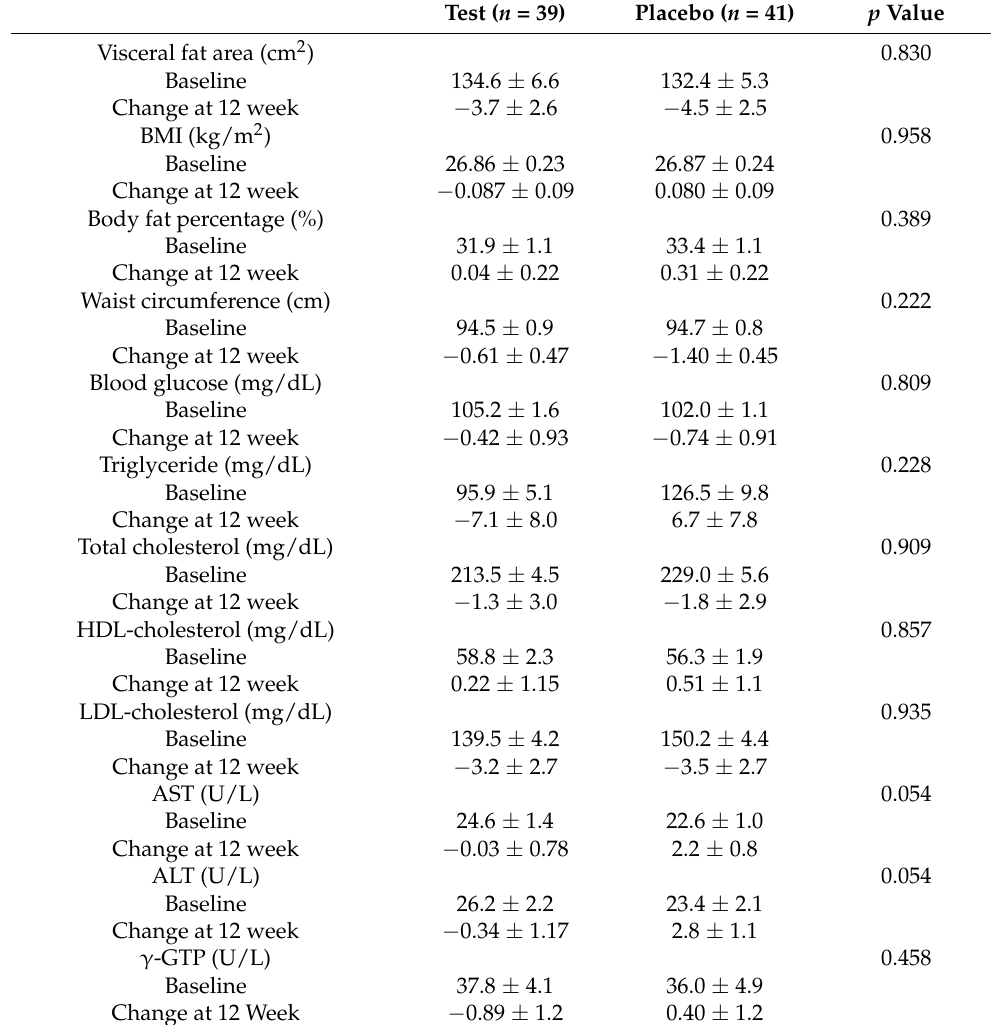
Table 2. Changes in primary and secondary